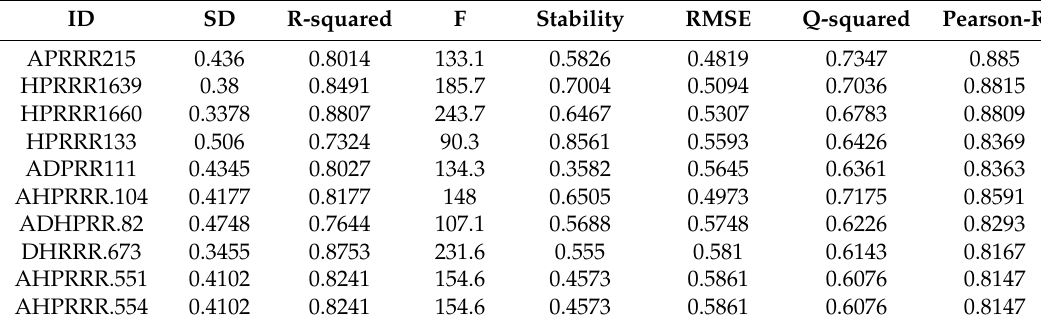
Table 2. Means of statistic variations of QSAR models.